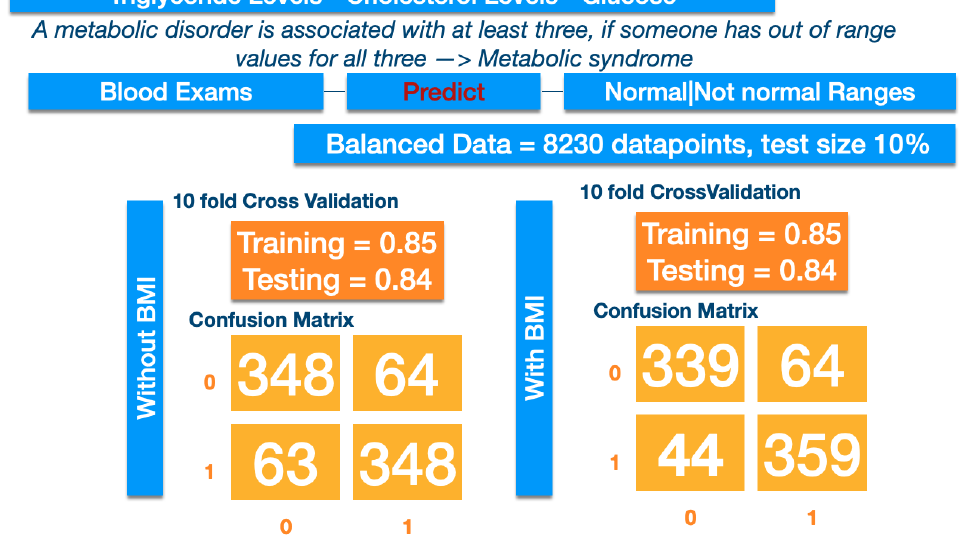
Figure 14. MetS classifier—total cholesterol.